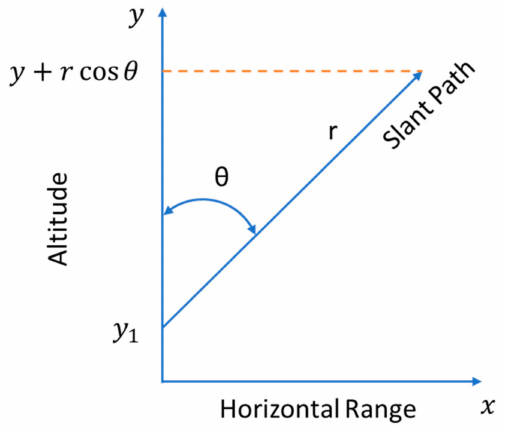
Figure 23. Geometry of a laser beam propagation along a slant path adapted from